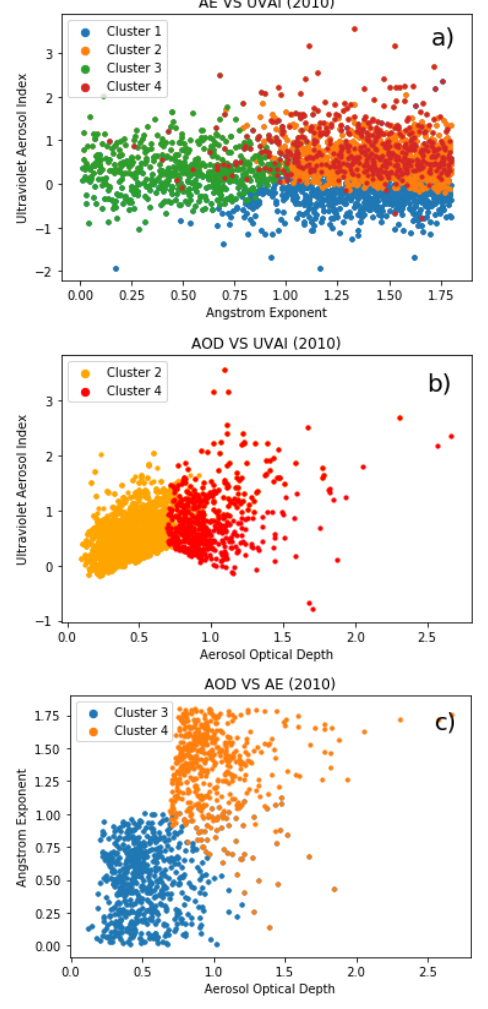
Figure 3. Scatter plots of different dimension combination in 2010, (a) AE VS UVAI, (b) AOD VS UVAI, (c) AOD VS AE